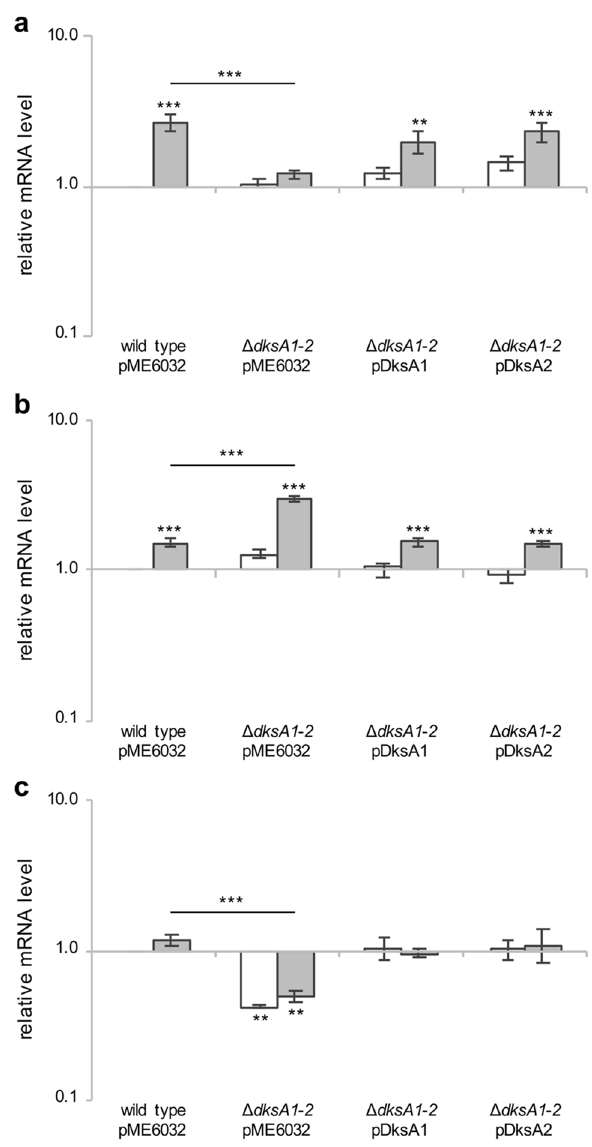
Figure 5. Expression analysis of oxidative stress response genes. Bacterial cultures were grown to the exponential phase (OD 600 ≈ 2.5) in LB supplemented with 0.1 mM IPTG, then incubated with or without 1 mM H 2 O 2 for 20 min. The mRNA levels of katA ( a ), katB ( b ) and katE ( c ) were determined by Real Time PCR analysis. Gene expression in the indicated untreated (white bars) or treated (grey bars) strains was reported as fold change in gene expression relative to the level of each gene in the untreated wild type PAO1(pME6032) strain. The average of two independent analyses, each performed on three technical replicates, is reported with standard deviations. Asterisks above the horizontal lines refer to p values versus wild type challenged with 1 mM H 2 O 2 ; asterisks above the bars refer to p values versus the untreated wild type; ** p < 0.01, *** p < 0.001